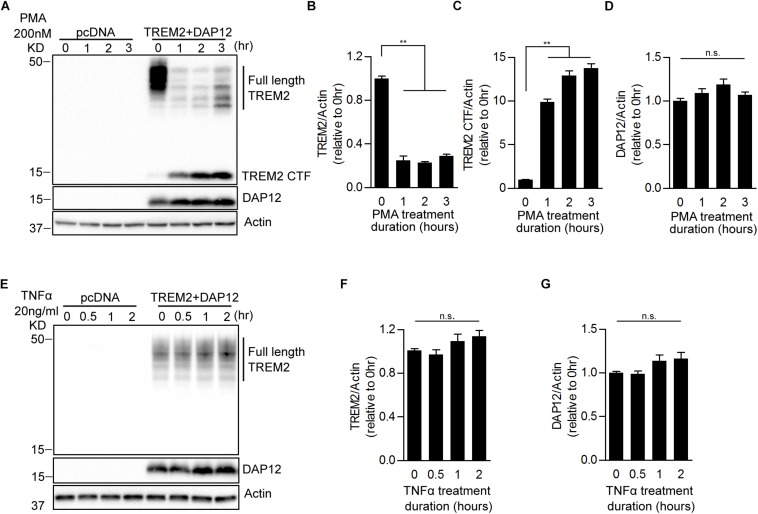
Effects of PMA and TNFα treatments on the shedding of TREM2 in HEK293 cells overexpressing TREM2 + DAP12. (A) A representative western-blot showing the effects of PMA on full length TREM2 and TREM2-CTF is shown. Control pcDNA (empty vector) and TREM2 + DAP12 transfected HEK293 cells were treated with PMA (200 nM) for different timepoints (0, 1, 2, and 3 h). The histograms represent the quantification of western-blot data and show the amount of full length TREM2 normalized to Actin (B), TREM2-CTF levels normalized to Actin (C), and DAP12 levels normalized to Actin (D). Data are represented as means ± SD and expressed relative to the 0-h timepoint; n = 4 for each experimental condition; statistical significance (∗∗p < 0.01; n.s., not significant) was evaluated by ANOVA followed by post hoc analyses using Bonferroni corrections. (E) Western blot analysis of lysates from TREM2 + DAP12 transfected HEK293 cells treated with TNFα (20 ng/ml) for different timepoints (0, 0.5, 1, and 2 h). The histograms depict the quantification of full length TREM2 levels normalized to Actin (F) and DAP12 levels normalized to Actin (G). Data are represented as means ± SD and expressed relative to 0-h timepoint; n = 4 for each experimental condition; statistical significance (n.s., not significant) was evaluated by ANOVA.